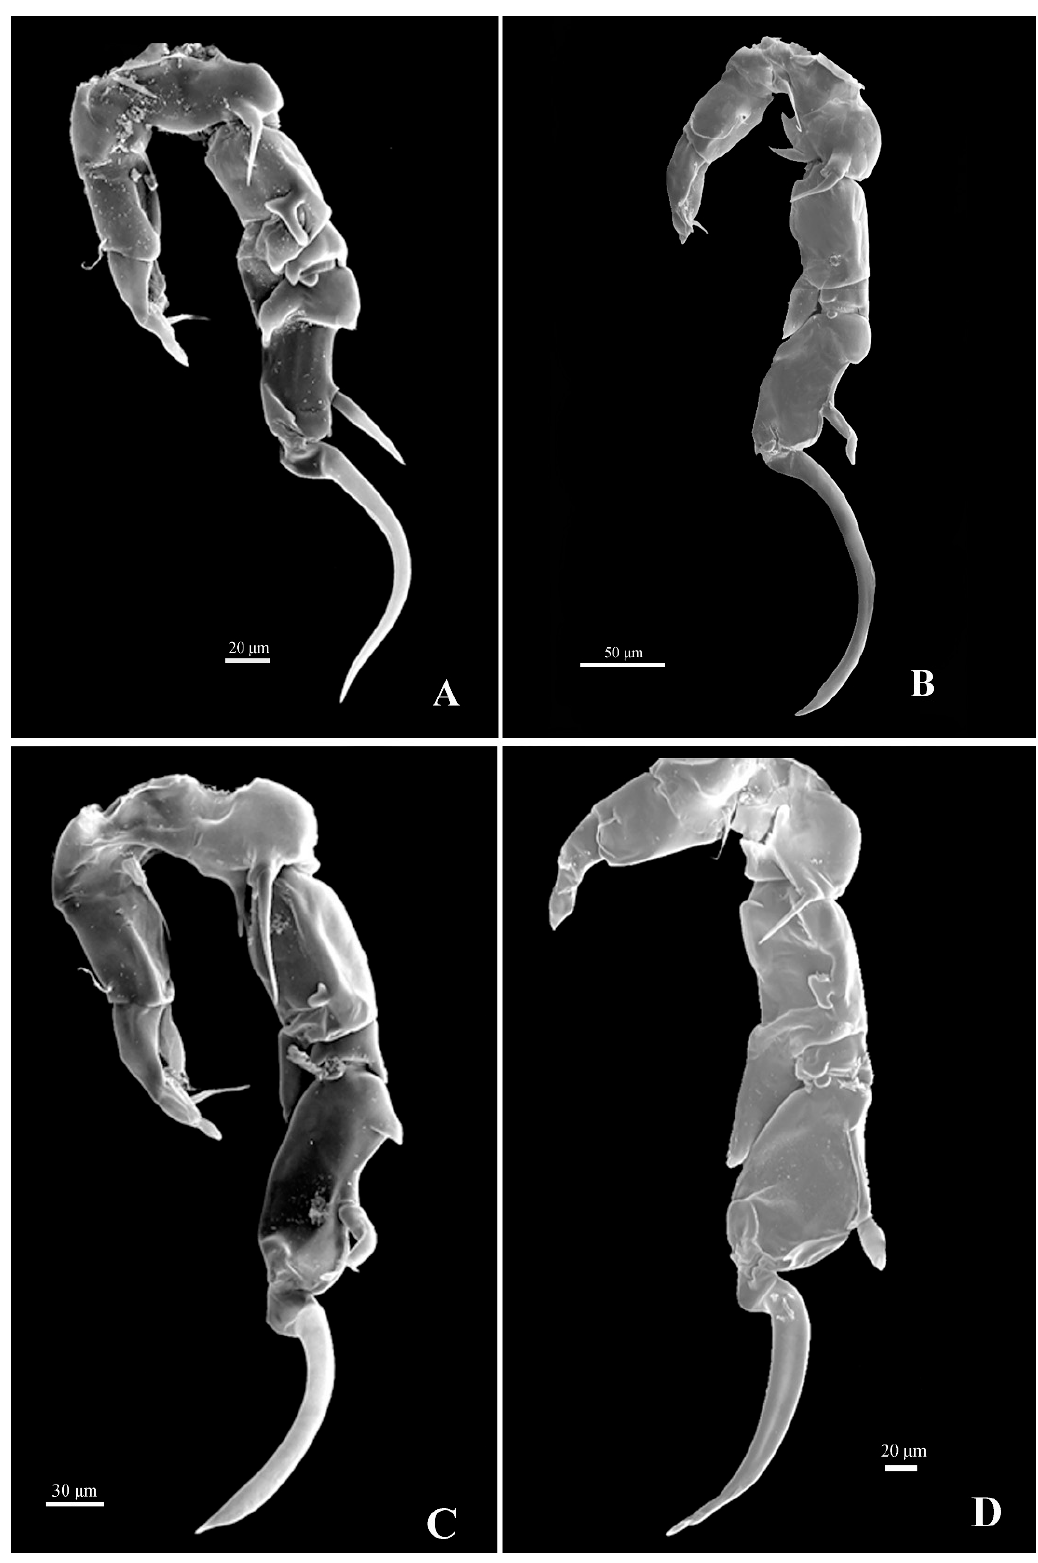
Figure 4. SEM photographs of the male leg 5 (P5) of four species of the genus Mongolodiaptomus: ( A ) M. dumonti ; ( B ) M. loeiensis ; ( C ) M. mekongensis ; and ( D ) M. pectinidactylus .